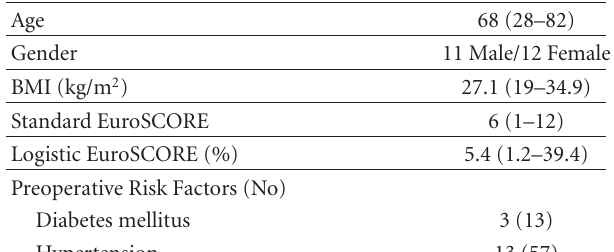
Table 1: Demographic data and cardiovascular risk factors. Data are presented as absolute numbers (percentage) or median (range), as